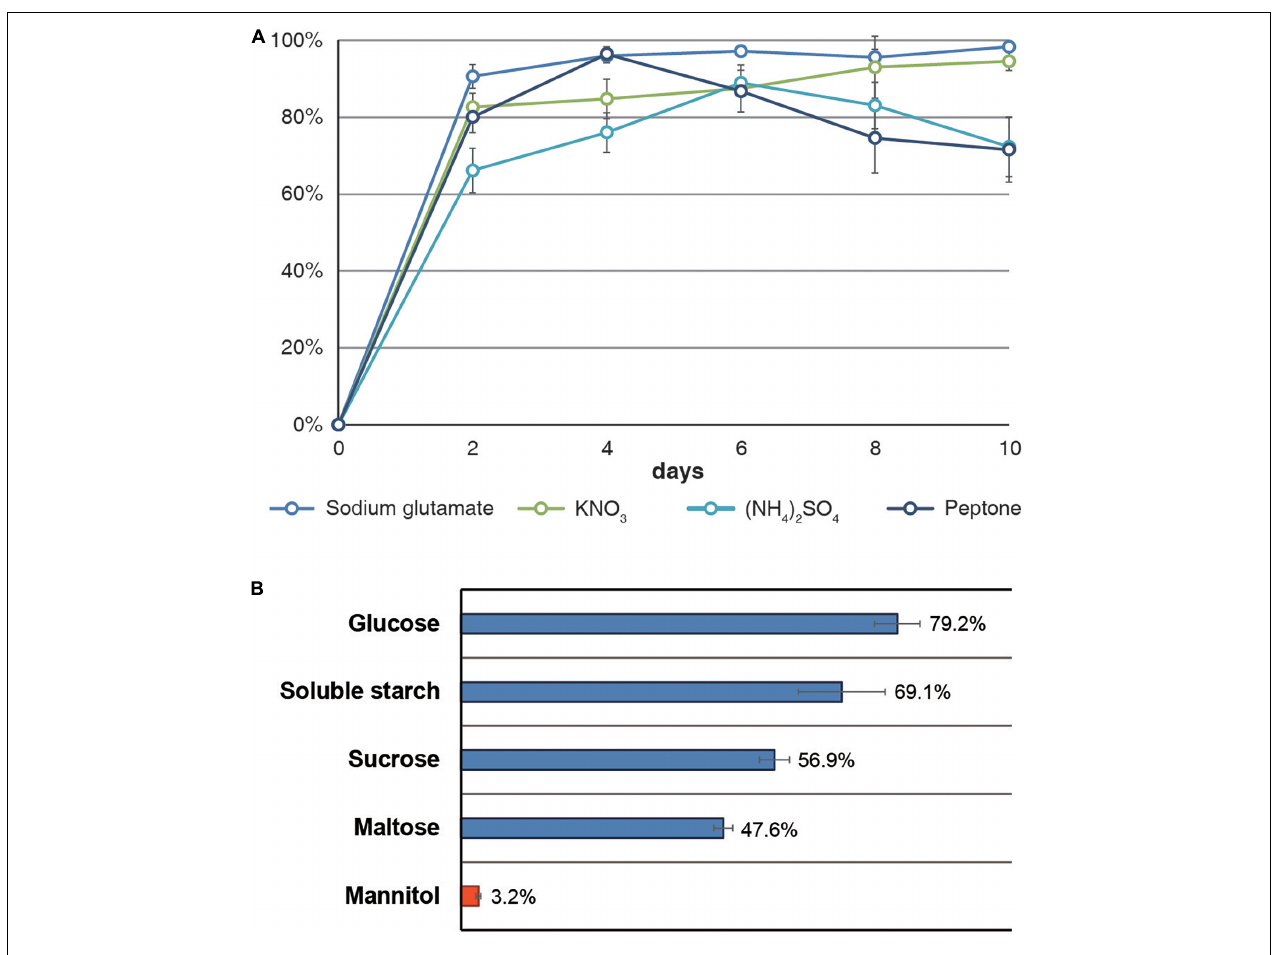
FIGURE 4 | DPPH radical-scavenging activities of Arthrinium koreanum KUC21332 culture extracts. (A) Activities by nitrogen source with glucose as a carbon source. (B) Activities by carbon source after being cultured for 3 days with sodium glutamate as a nitrogen